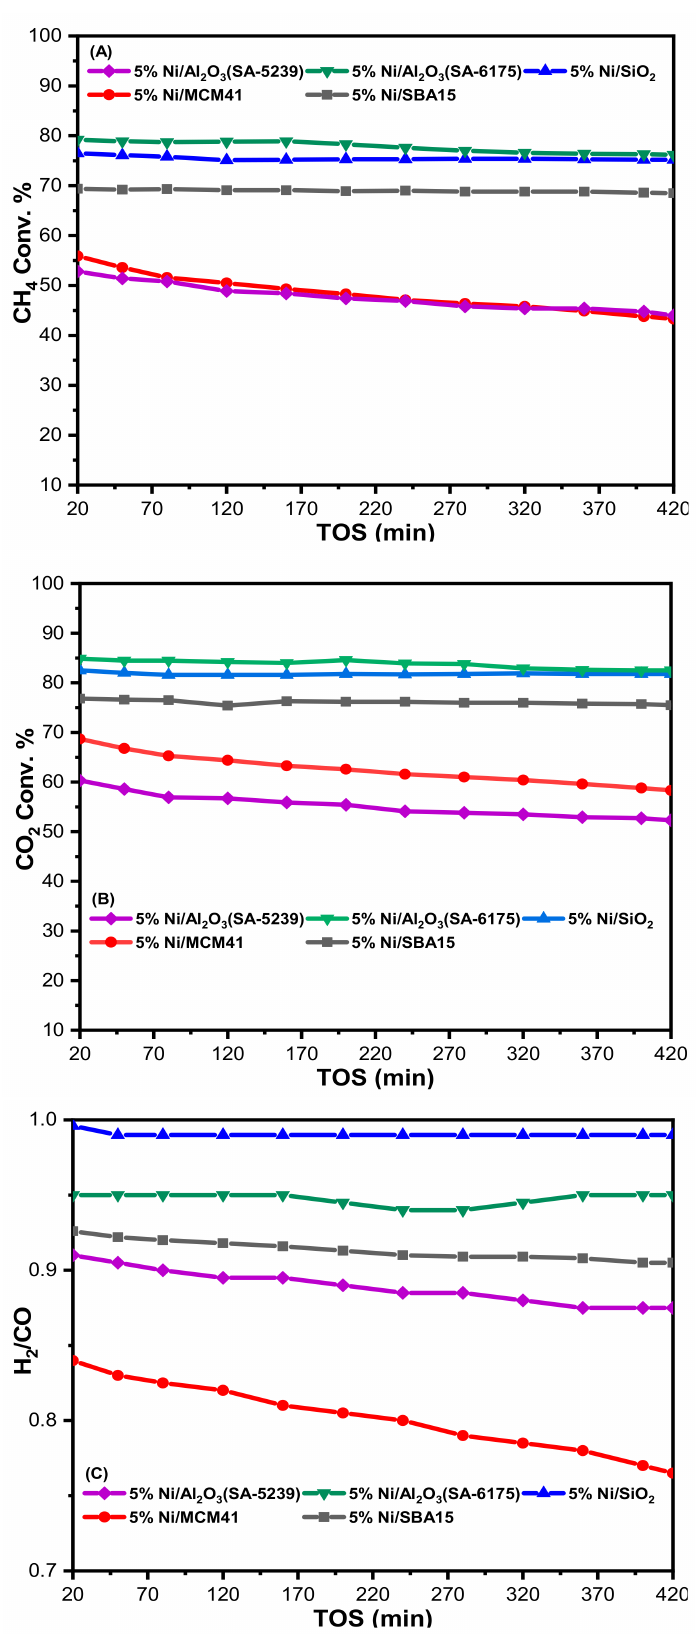
Figure 5. ( A ) CH 4 conversion, ( B ) CO 2 conversion, and ( C ) H 2 / CO ratio at atmospheric pressure, 700 ◦ C, and GHSV = 39,000 mL / gcat h. (TOS: time on stream, GHSV: gas hourly space